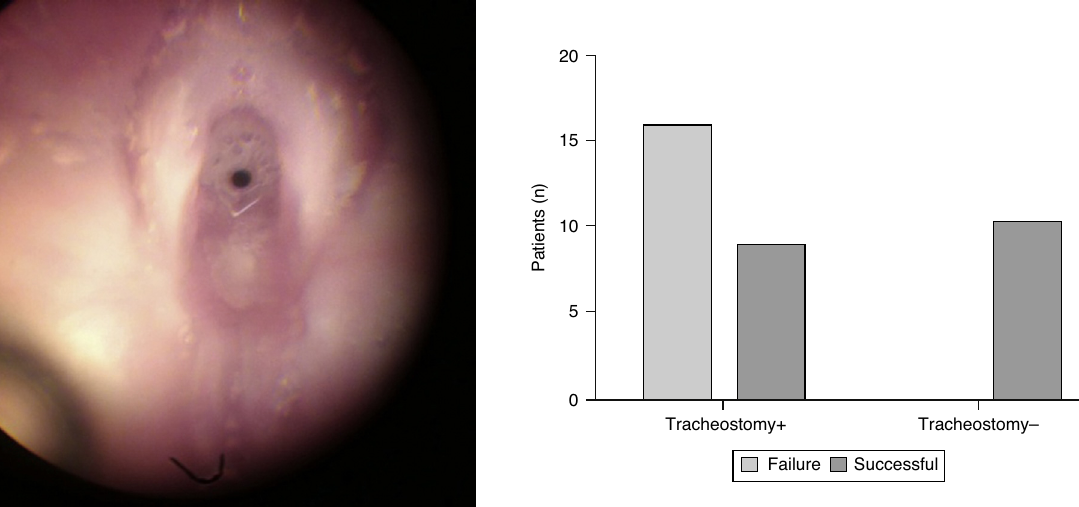
Figure 6 Correlation between the presence of tracheostomy and successful balloon laryngoplasty ( p =